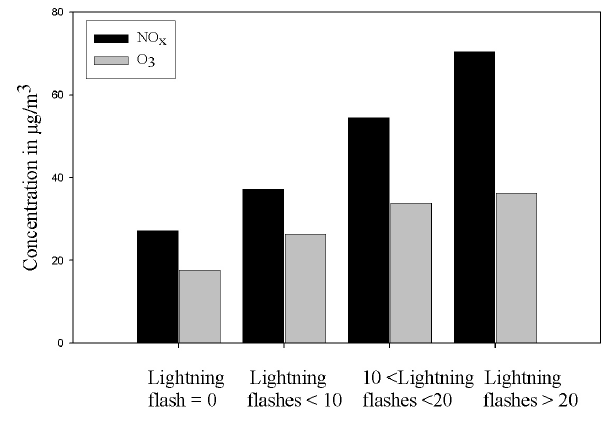
Figure 9. Variation of daily average concentrations of NO x and O 3 with four categories of lightning days during premonsoon